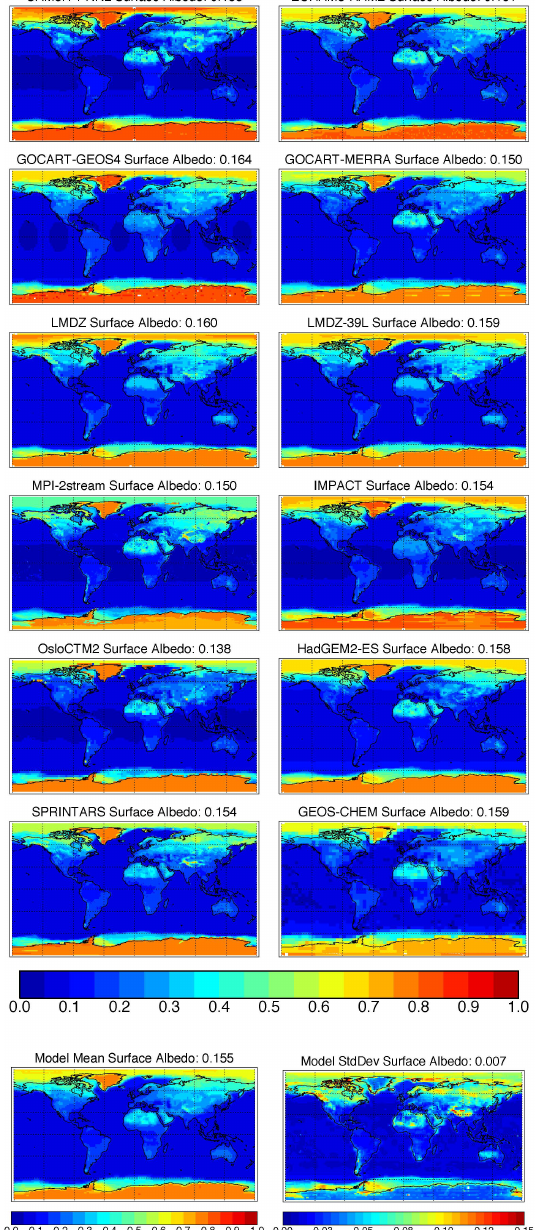
Fig. 3. Annual mean broadband short-wave surface albedos for ex- periment FIX0